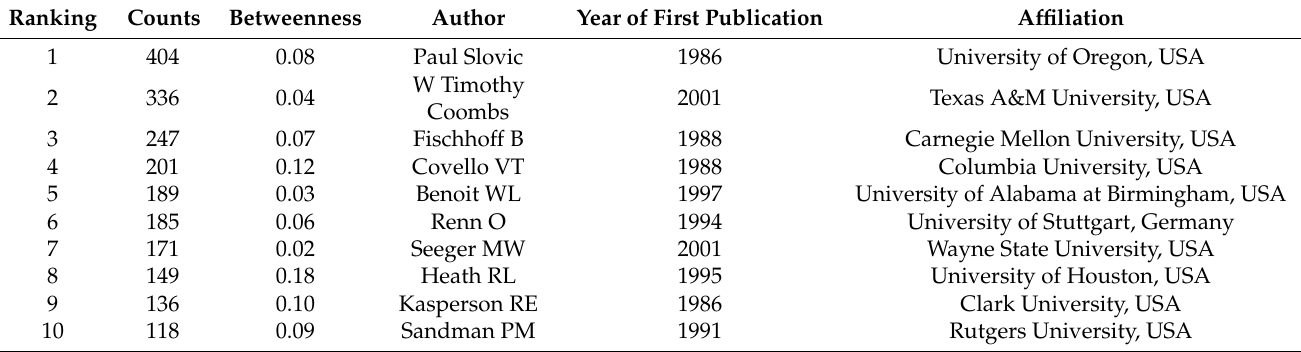
Table 10. Top 10 co-cited authors in crisis and risk communication